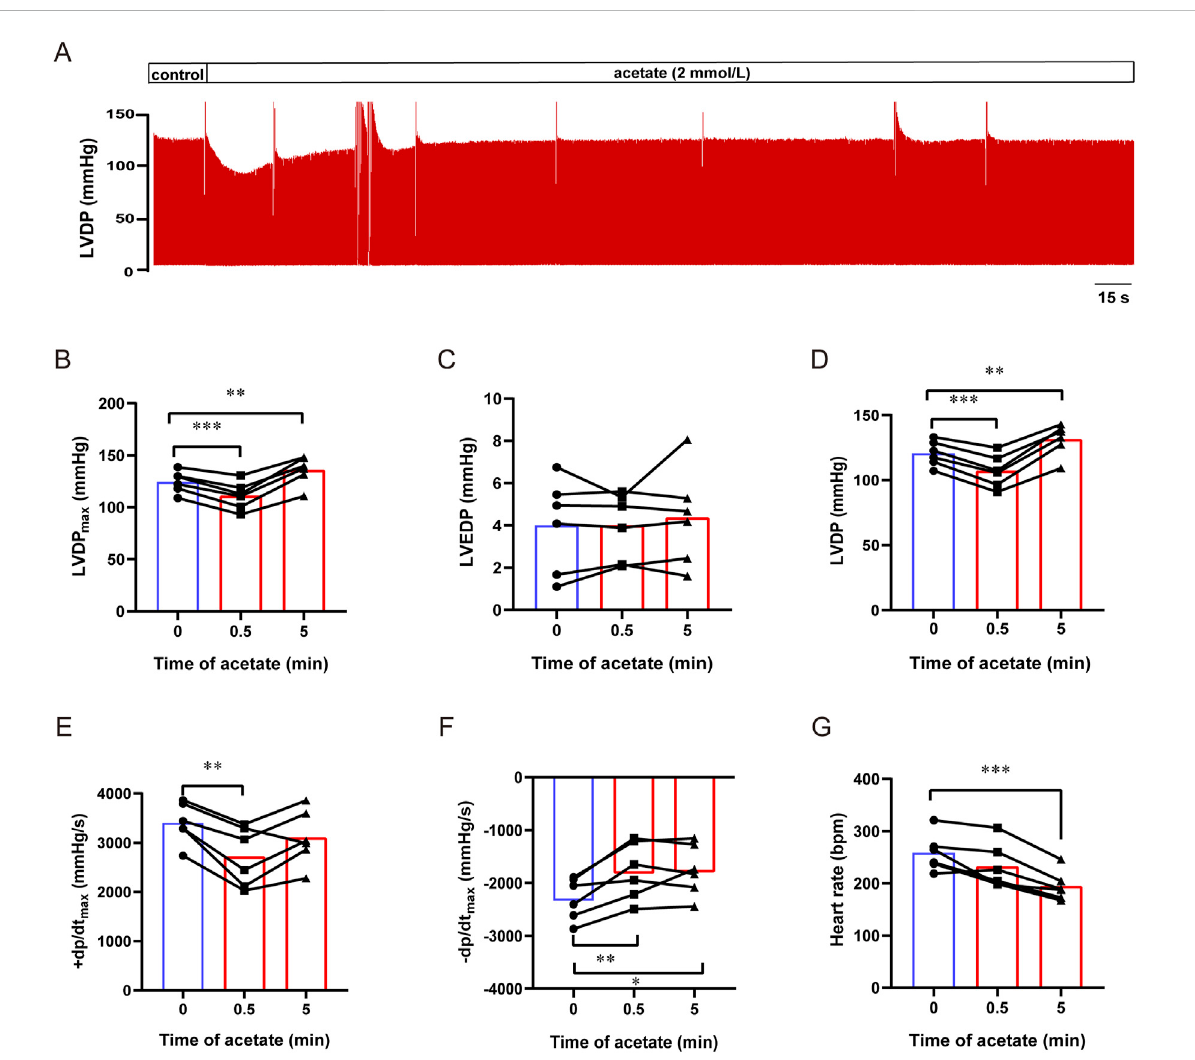
FIGURE 2 Acetate inhibited the contractility of Langendorff-perfused rat hearts. Representative traces of left ventricular pressure in isolated heart perfusion with acetate (A) . The maximal left ventricular developed pressure (B) , left ventricular end-diastolic pressure (C) , left ventricular developed pressure (D) , the maximal differentials of LVDP (E,F) , and heart rate (G) in Langendorff-perfused heart. N = 6. N: the number of rats. * p < 0.05, ** p < 0.01, *** p <